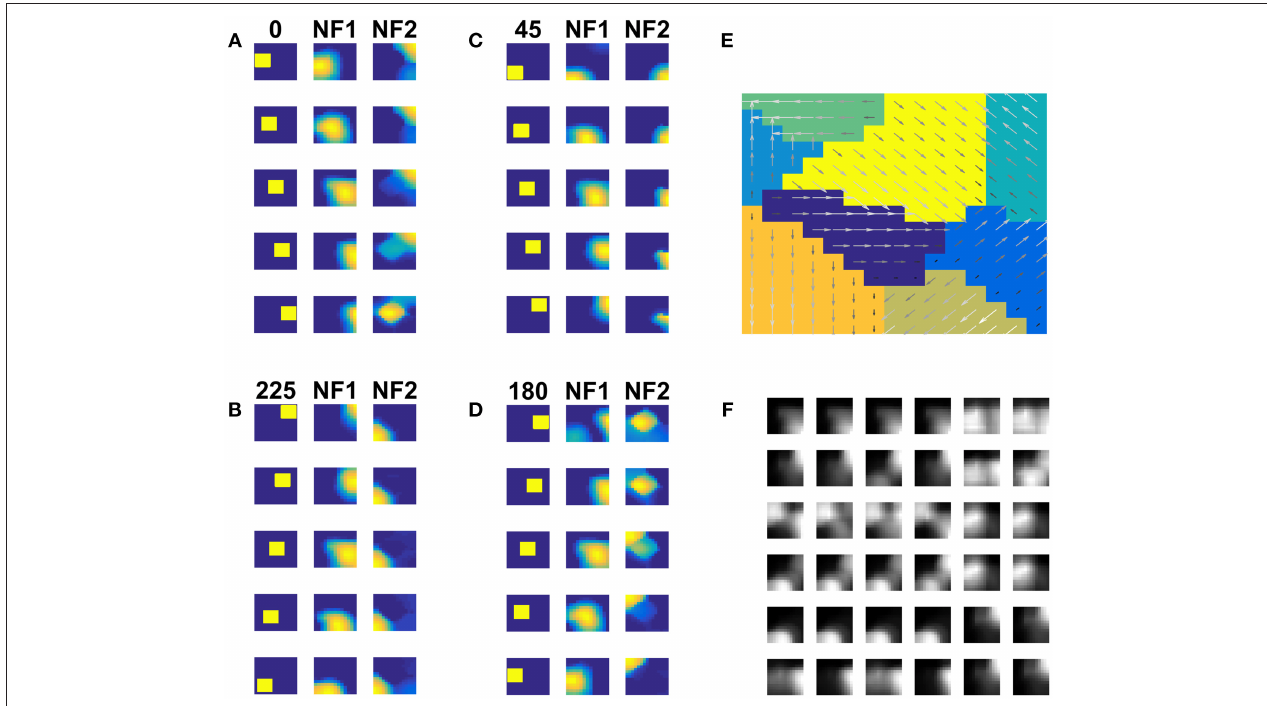
FIGURE 5 | NF2 response to moving Square stimuli. (A–D) are four clusters. In each cluster first column depicts the frames of moving squares stimuli (64 × 64 pixels), and the corresponding activity on NF1 (13 × 13 units), and NF2 (15 × 15 units) are shown in the next two columns. The label on the first column represents the direction of motion of a square object (A: 180 ◦ , B: 45 ◦ , C: 0 ◦ , and D: 225 ◦ ). Neurons in NF1 respond to local motion cues. At each frame presentation, different neurons receive afferent input from the square object and become active, according to its preferred direction of motion, thus the activity pattern follows the square stimulus. In NF2 neurons are selective to the entire object motion (also called pattern motion) by aggregating local motion cues from NF1. Nearly stabilized activity can be seen over the presentation of the whole moving square sequence. Different patches of neurons uniquely become selective to different directions of square motion. (E) Shows the pattern selectivity map plotted out of NF2 neuron responses to moving square stimuli. The arrows indicate the neuron preferences to 8 motion directions: 0, 45, 90, 135, 180, 225, 270, and 315 ◦ . The magnitude of the arrow represents the activity of the neuron. Peak activity is represented by neurons with the highest magnitude. (F) Represents the NF2 afferent weights (13 × 13 pixels each) of the selected neurons. It shows that the NF2 neurons developed spatiotemporal receptive fields in the direction of pattern motion.